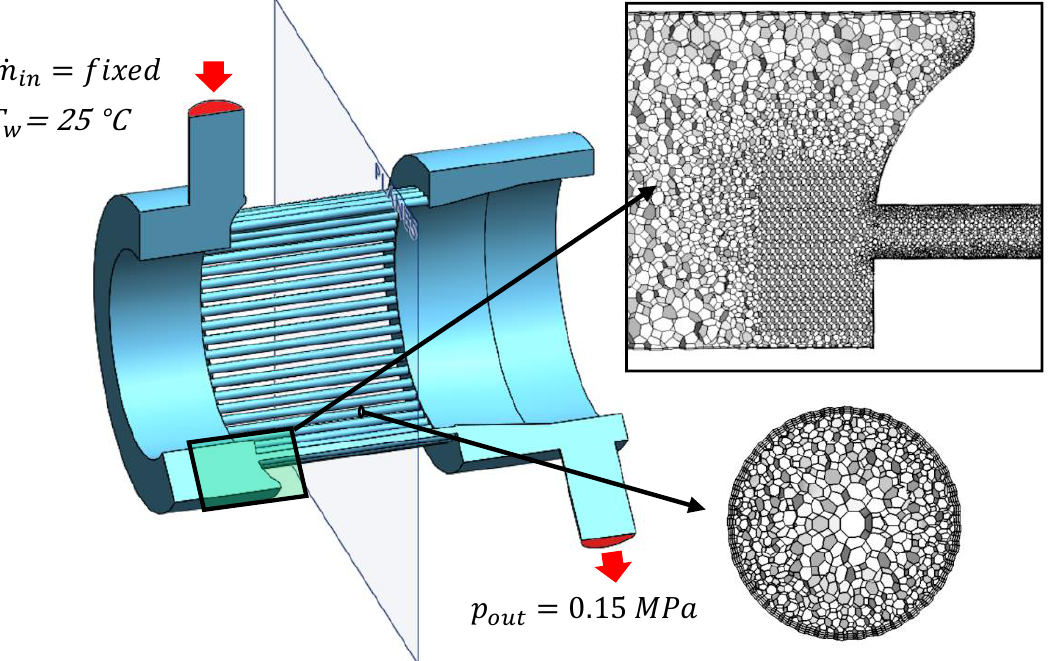
Figure 13. Section of the computational domain of the mock-up equipped with MCs. Insets: details of the computational mesh.